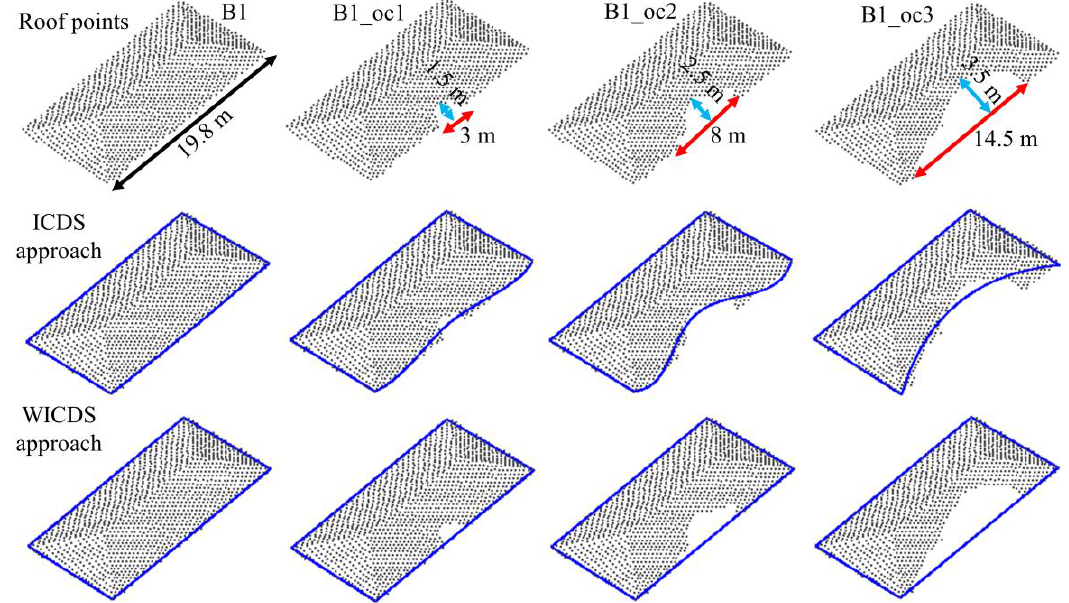
Figure 5. Rectangular building with different sizes of occlusion areas. Roof points ( First row ), modeled boundary (blue line) using ICDS ( Second row ) and WICDS ( Third row ).